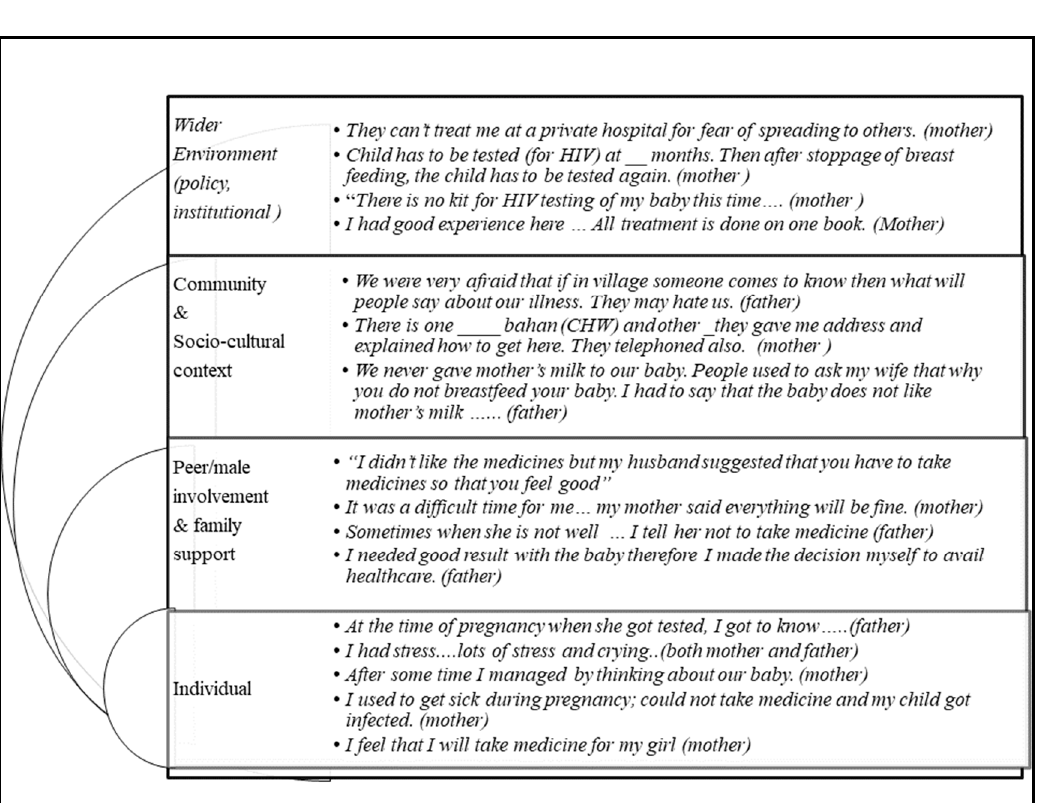
Figure 3. Barriers and Facilitators of Engagement in Prevention of Mother/Parent to Child Trans- mission (PMTCT/PPTCT) of HIV Services.